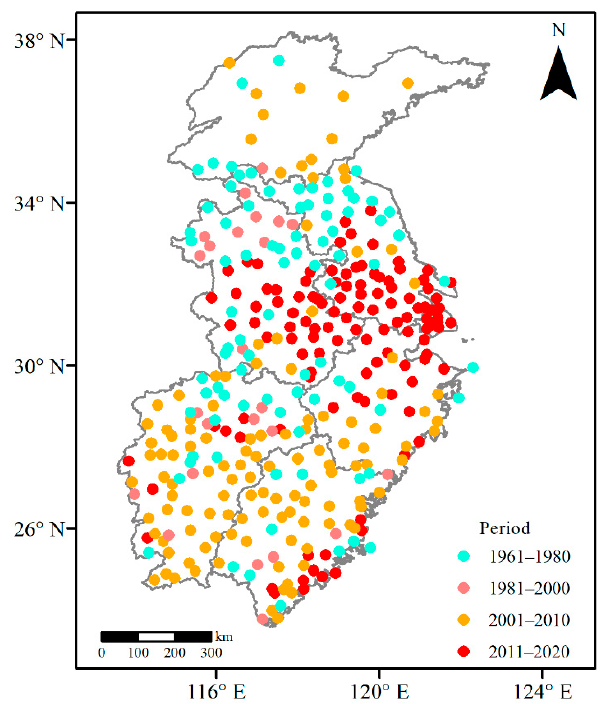
Figure 7. Years of occurrence of maximum extreme maximum temperature event intensity in East China during the period 1961–2020.